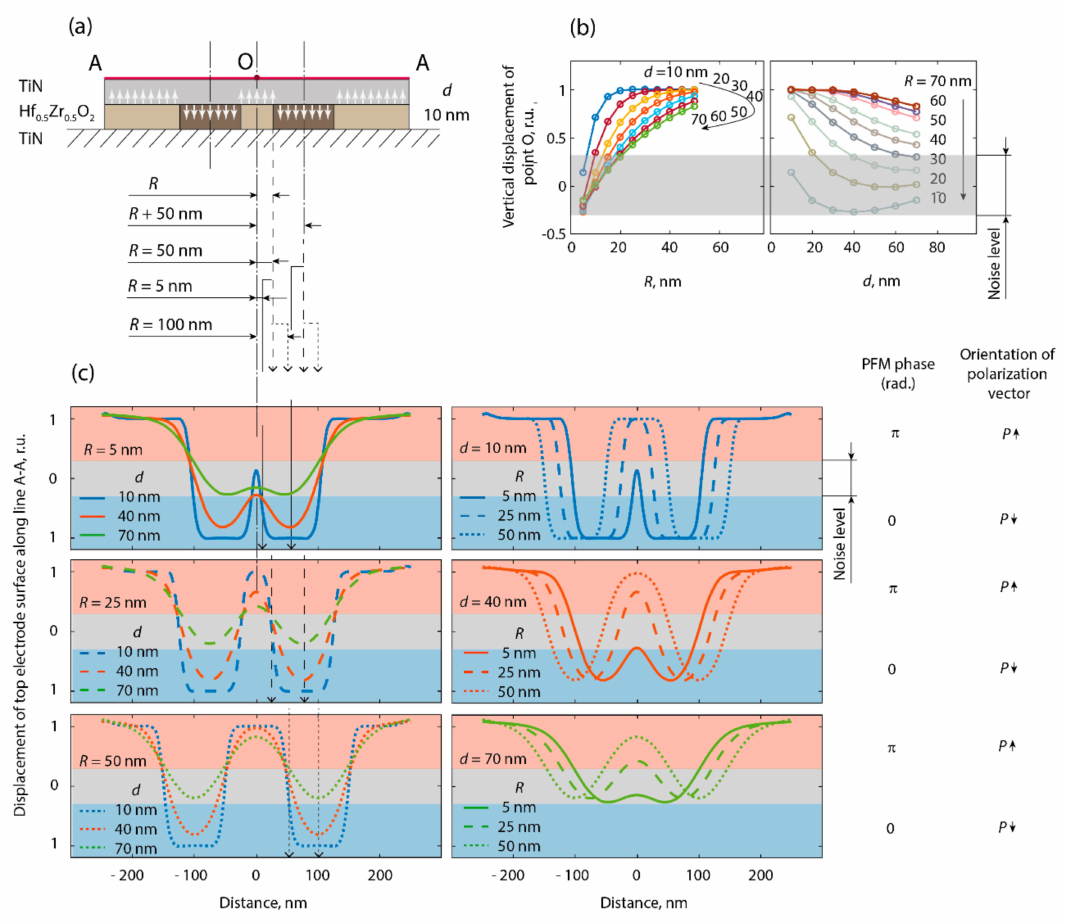
Figure 4. On the spatial resolution of PFM of capacitor devices: ( a ) geometry for the finite element simulation, (b ) calculated dependences of relative vertical displacement of central point of top electrode above a single domain (point O) on domain size and thickness of top electrode, ( c ) calculated relative displacement of the surface of top electrode (line A–A) at different lateral sizes of the central domain and thickness of top electrode. Displacements of 0–1 and 0–1 r.u. correspond to the PFM phase of π and 0 and thus to the up- and downward orientation of vertical component of polarization, respectively. Orange and blue coloring correspond to similar colors on PFM-phase maps. Gray color indicates a noise